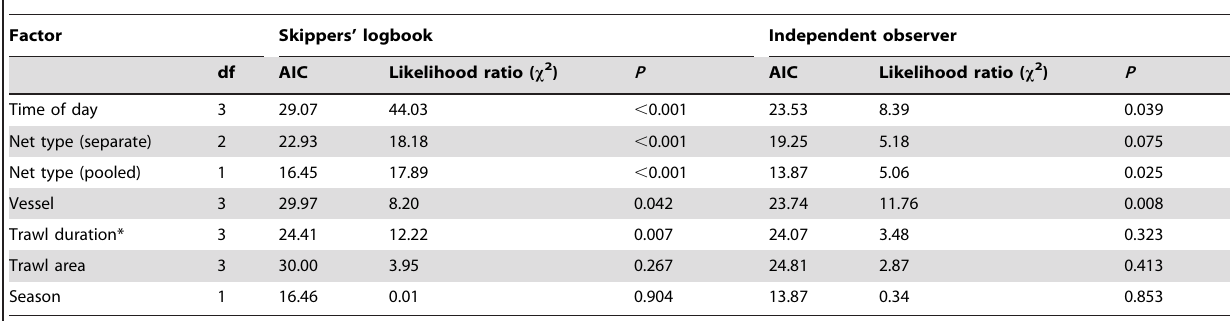
Table 3. Presence of dolphin bycatch by individual